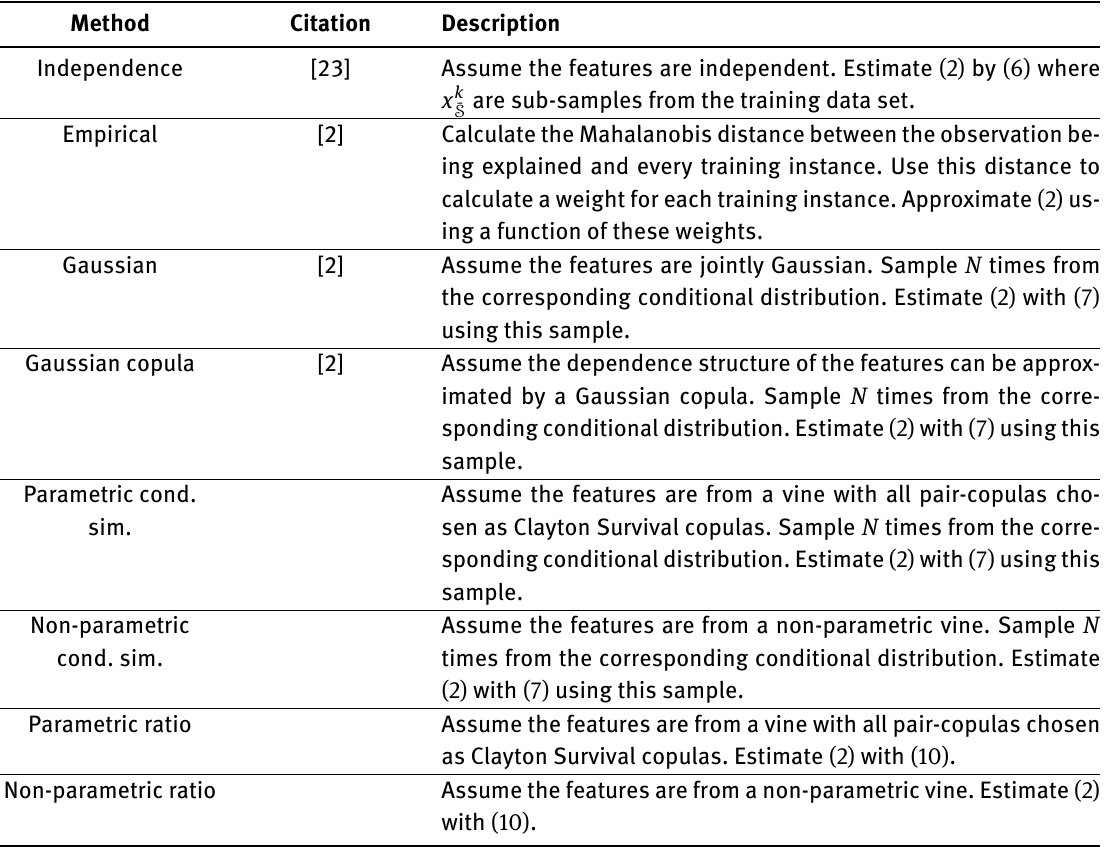
Table 1: A short description of the approaches used to estimate (2) in the simulation